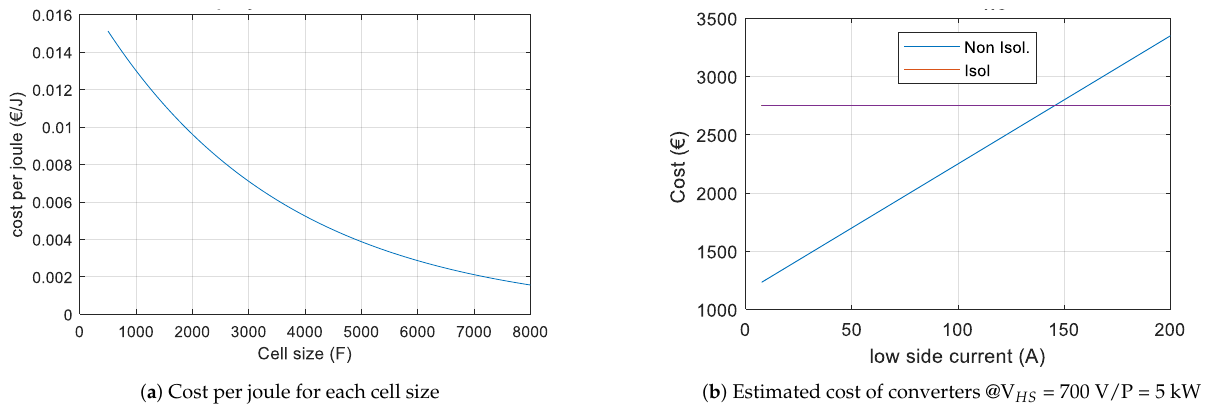
Figure 4. Flow chart of the optimization procedure.